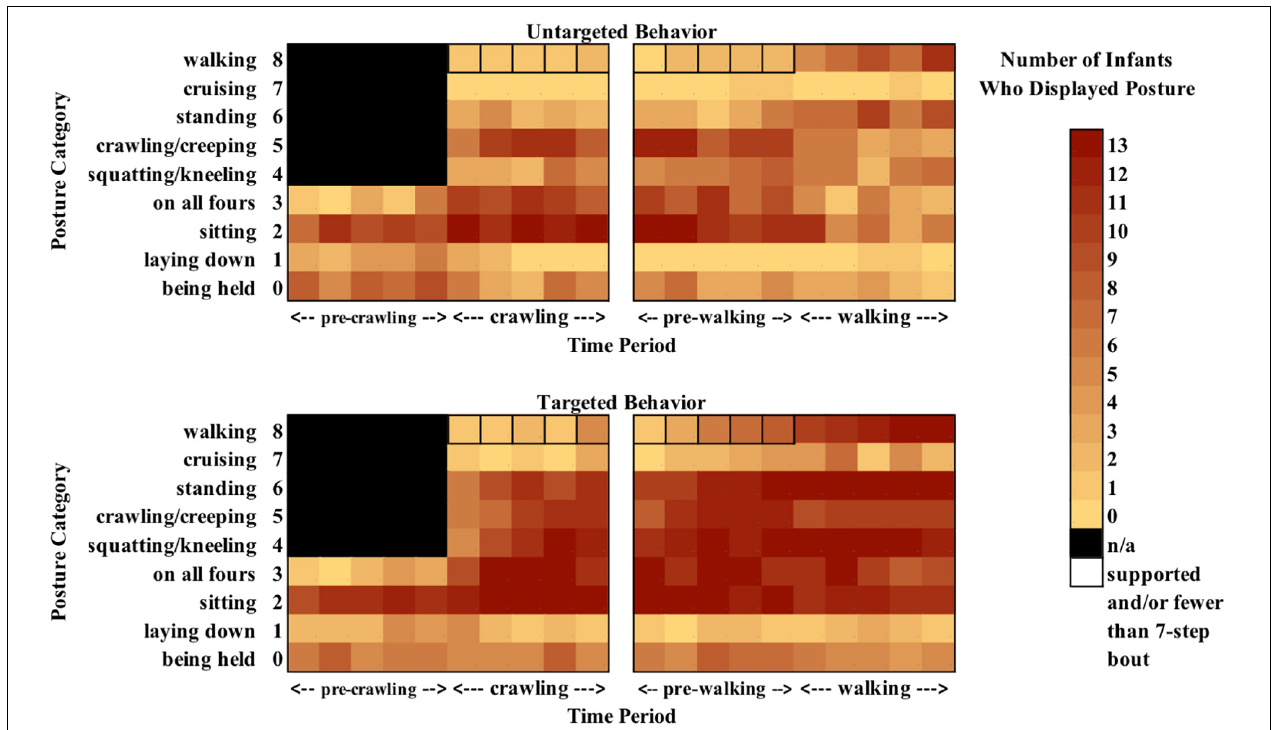
FIGURE 3 | Heat maps representing the number of infants who displayed a given posture during a given session when engaging in untargeted (top) vs. targeted (bottom) behavior around the transition to crawling (left) and walking (right). Lighter colors indicate that fewer infants displayed a given posture.